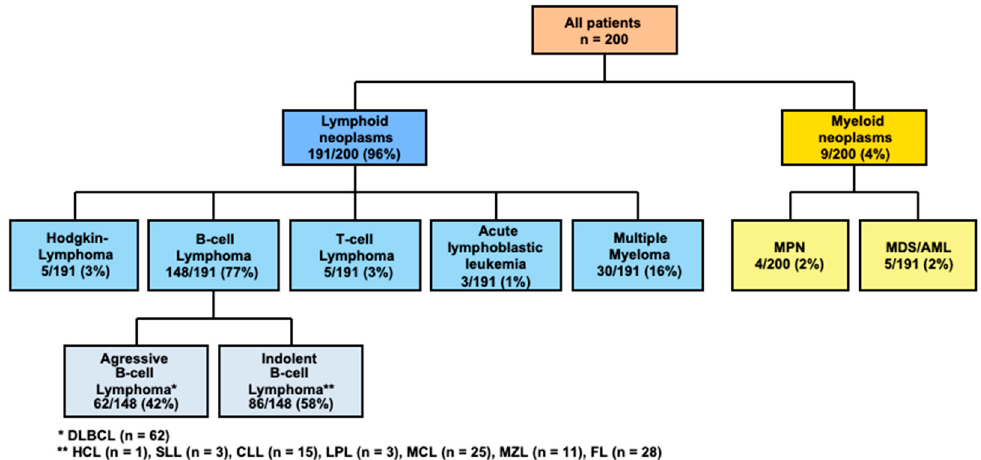
Figure 1. Overview of all patients and entities included in this study. DLBCL, diffuse large cell B-cell lymphoma; HCL, hairy cell leukemia; SLL, small lymphocytic lymphoma; CLL, chronic lymphocytic leukemia; LPL, lymphoplasmocytic lymphoma; MCL, mantle cell lymphoma; MZL, marginal zone lymphoma; FL, follicular lymphoma.